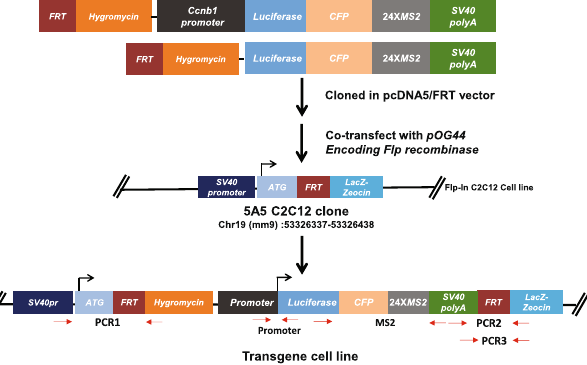
Figure 1. Generating a C2C12 cell system that allows integration of single-copy promoter transgenes at an identified locus. Diagrams of constructs and the transgene locus are shown. Mouse Ccnb1 promoter (~2.8 Kb) was cloned upstream of the Luciferase coding region in the pcDNA5 / FRT vector. 24X MS2 repeat sequence was cloned downstream of the Luciferase coding region and before the SV40 late poly(A) signal. As a control, we insertion of the pFRT/LacZeo vector at mouse chromosome 19 (~53 Mb). Locations of primers used to validate the correct integration of transgenes are shown by red